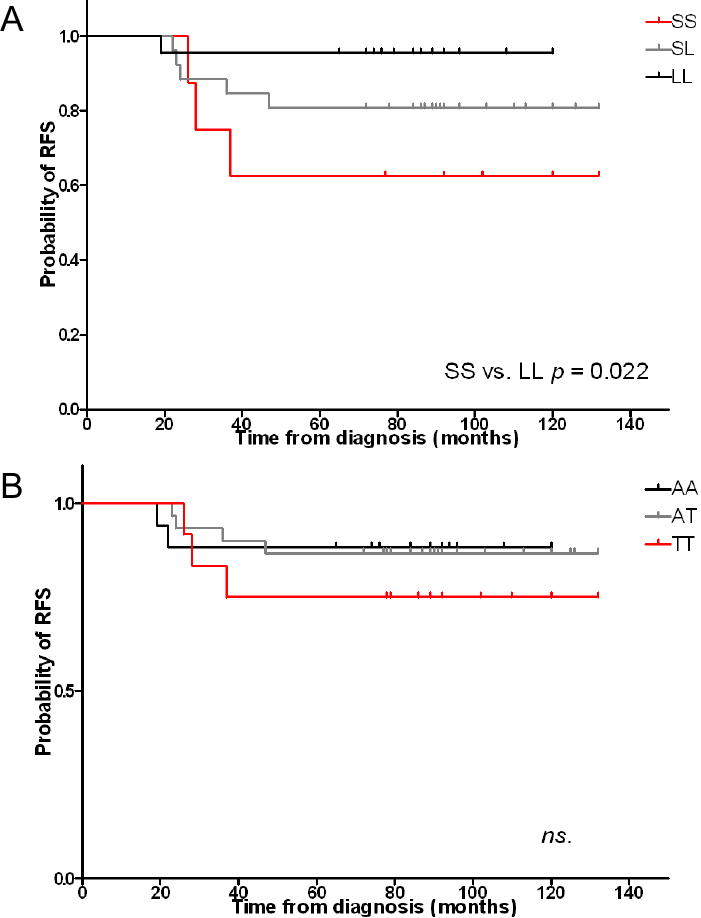
Figure 1. Relapse-free survival by grouping patients according to the presence of ( A ) length poly- morphism and ( B ) SNPs polymorphisms. ( A ) The 5-year actuarial probability of relapse-free survival was 62.5%, 80.7% and 95.5% for patients with SS (red line, n = 8), SL (gray line, n = 26) and LL (black line, n = 22) genotype, respectively. ( B ) The 5-year actuarial probability of relapse-free survival was 88.2%, 86.7% and 75% for patients with TT (red line, n = 12) genotype, AT (gray line, n = 30) and AA (black line, n = 17), respectively.